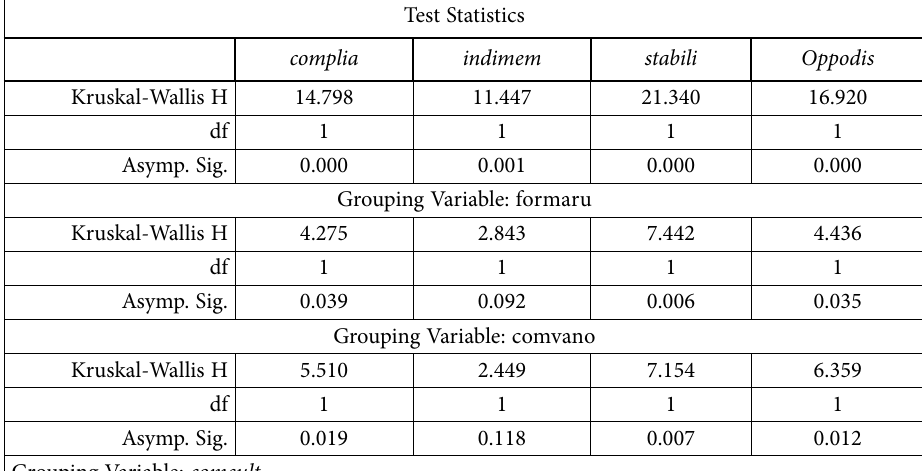
Table 9. Kruskal Wallis test – H3 (source: authors own